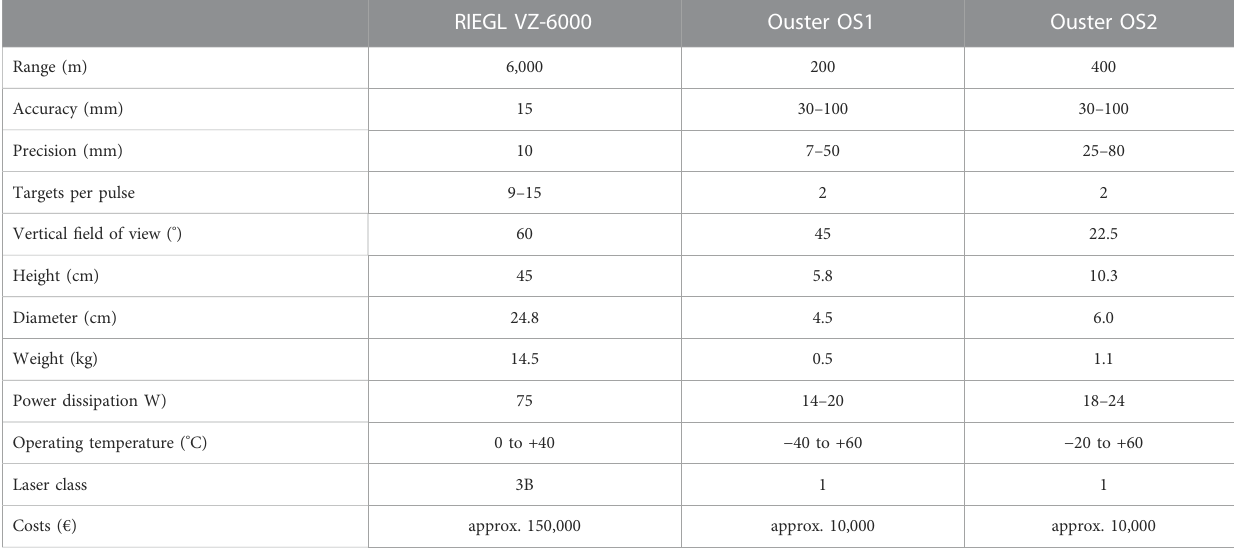
TABLE 2 Comparison between the RIEGL VZ-6000 (RIEGL Laser Measurement Systems GmbH, 2020) as a conventional TLS and the Ouster lidar OS1 (Ouster Inc., 2022a) and OS2 (Ouster Inc., 2022b) as automotive lidars. The form factors and weights are given without batteries, case, and